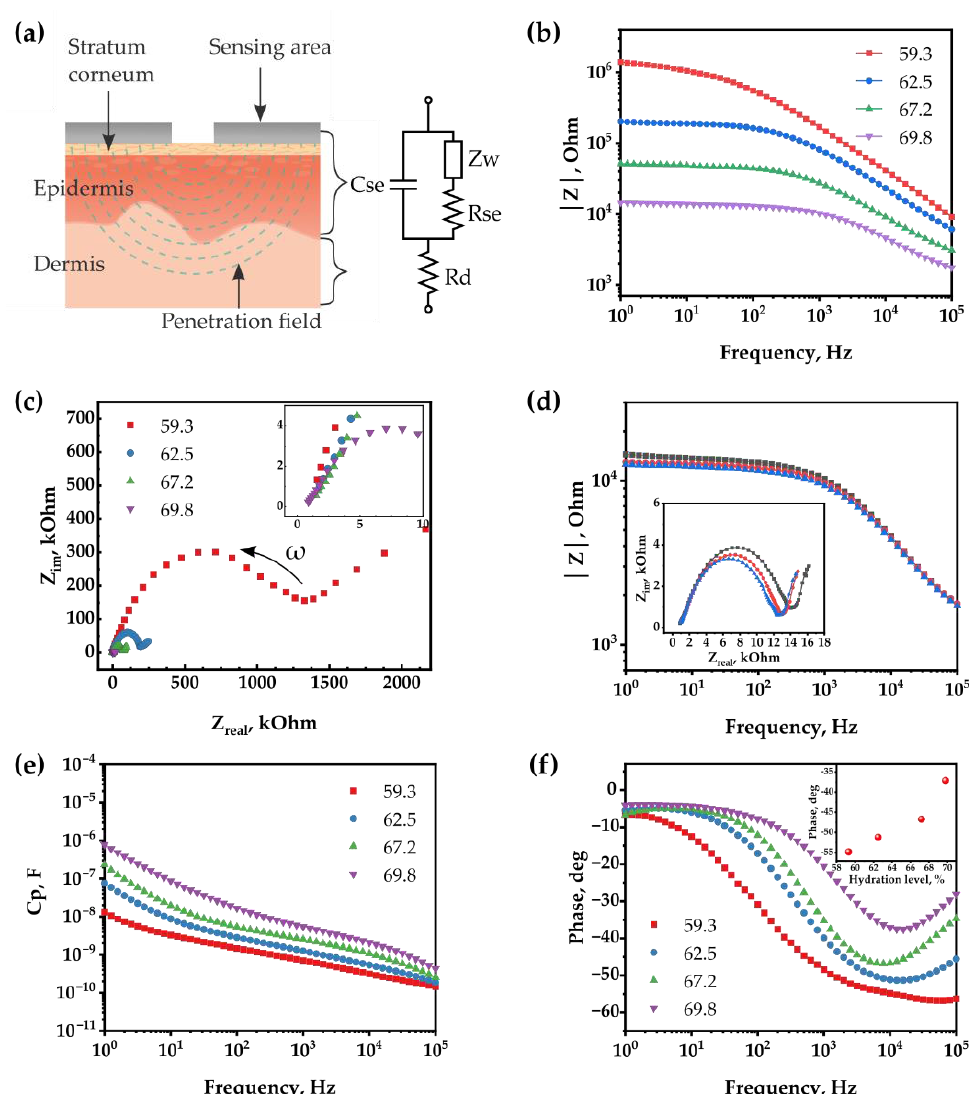
Figure 4. ( a ) Cross-sectional illustration of the skin – electrode system and its equivalent circuit. ( b ) Measured impedance according to the moisture content of the skin. ( c ) Nyquist plot. ( d ) Repeated measurement of total impedance and Nyquist plot (inset). ( e ) Capacitance changes and ( f ) phase values that vary with moisture content and frequency applied.